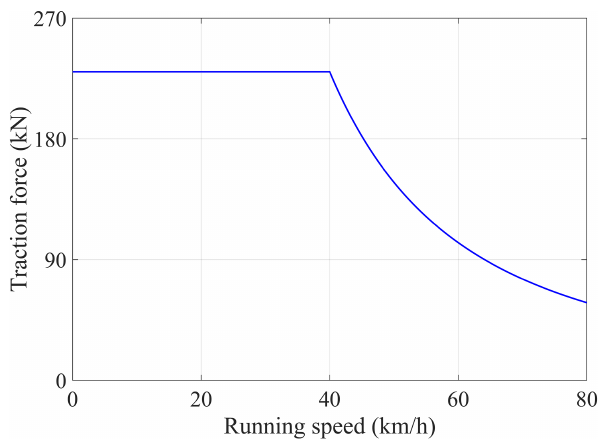
Figure 3. Traction characteristic curve of the metro vehicle (AW0).